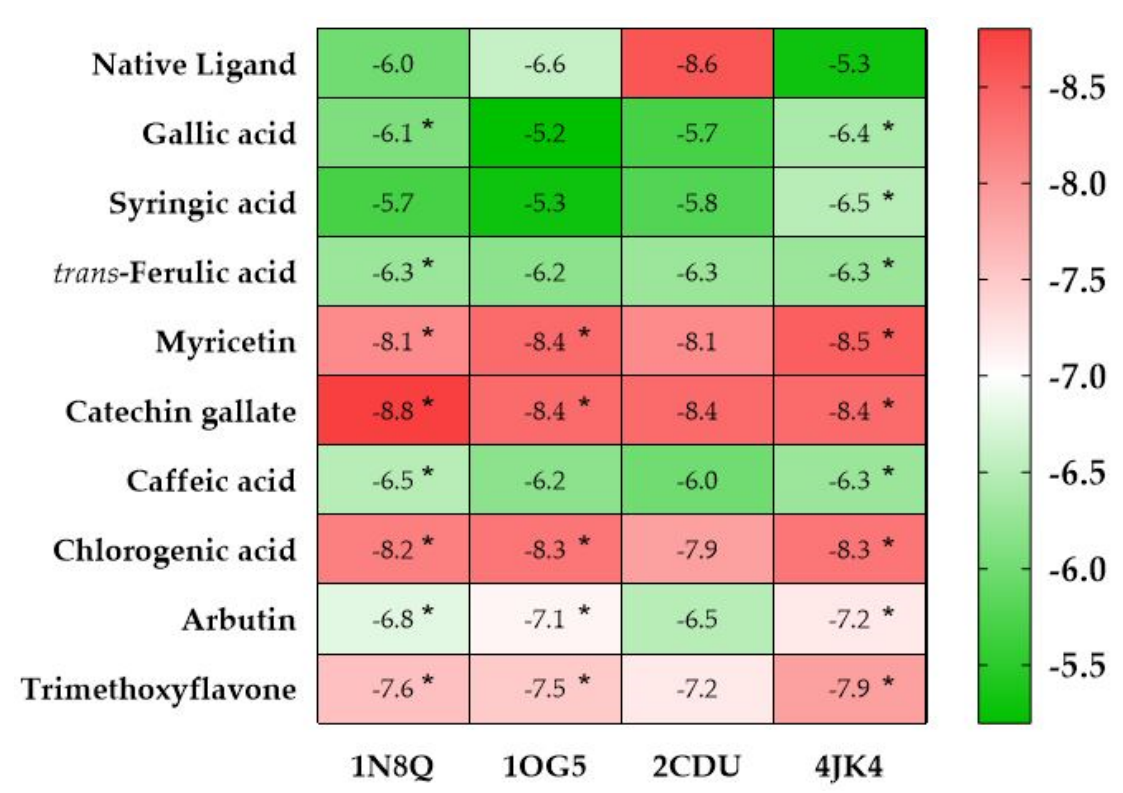
Figure 3. Heat map of the binding free energy values (expressed in kcal/mol) of A. halimus ethanolic extract phytoconstituents. 1N8Q , lipoxygenase; 1OG5 , CYP2C9; 2CDU , NADPH oxidase; 4JK4 , bovine serum albumin. Ligands with a docking score lower or equal to the native ligand’s score were highlighted with a star (*).